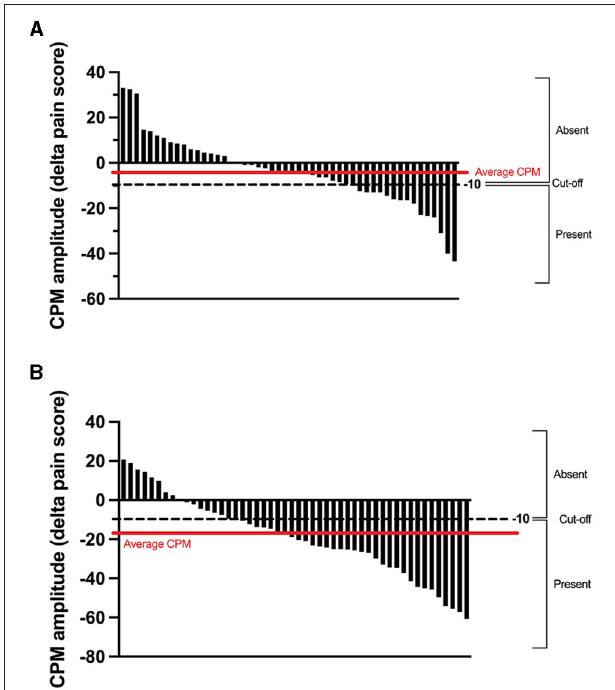
FIGURE 5 | Individual CPM obtained by subtracting the pre-CS TS pain score from the post-CS TS pain score in the TENS protocol (A) and the thermode/CPT protocol (B) . For CPM in the TENS protocol and the thermode/CPT protocol (calculated as the difference in pain levels evoked by the TS before and after the CS), a reduction in pain levels of 10 percentage points or more was classified as “CPM present.” CPM, conditioned pain modulation; CPT, cold pressor test; TENS, transcutaneous electrical nerve stimulation; CS, conditioning stimulus; TS, test